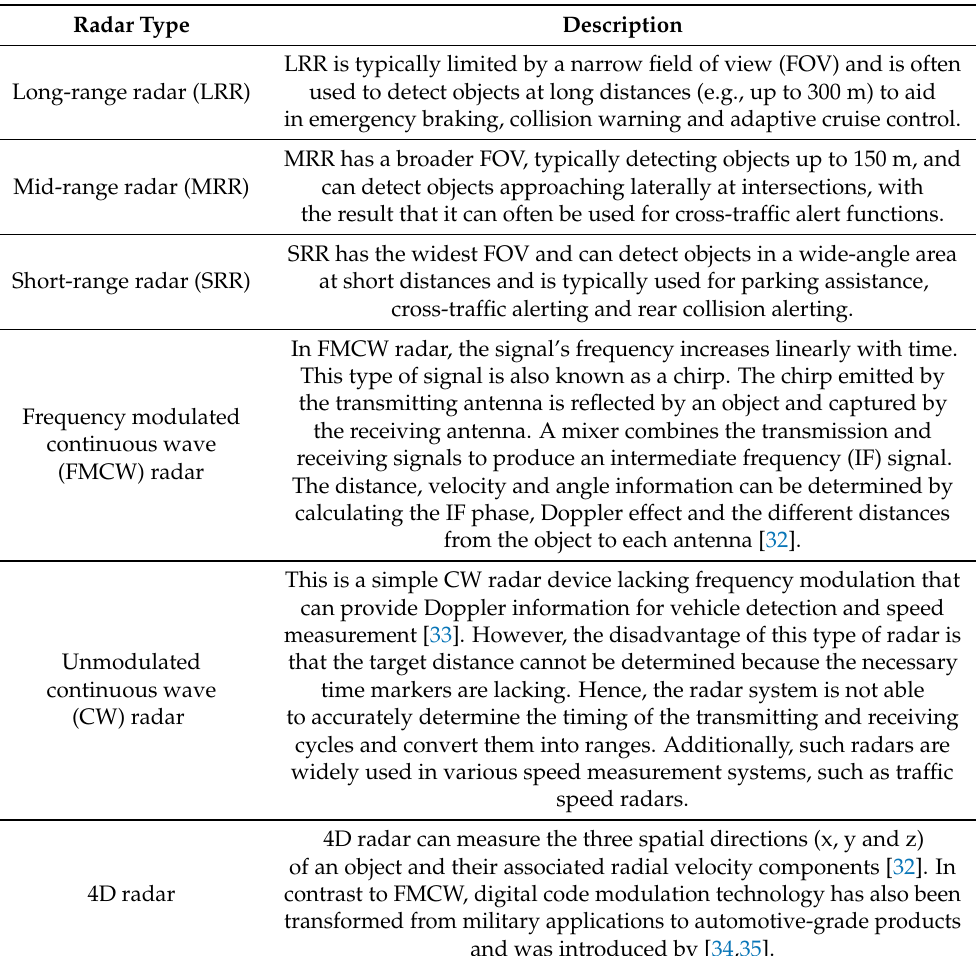
Table 2. Radar types used in